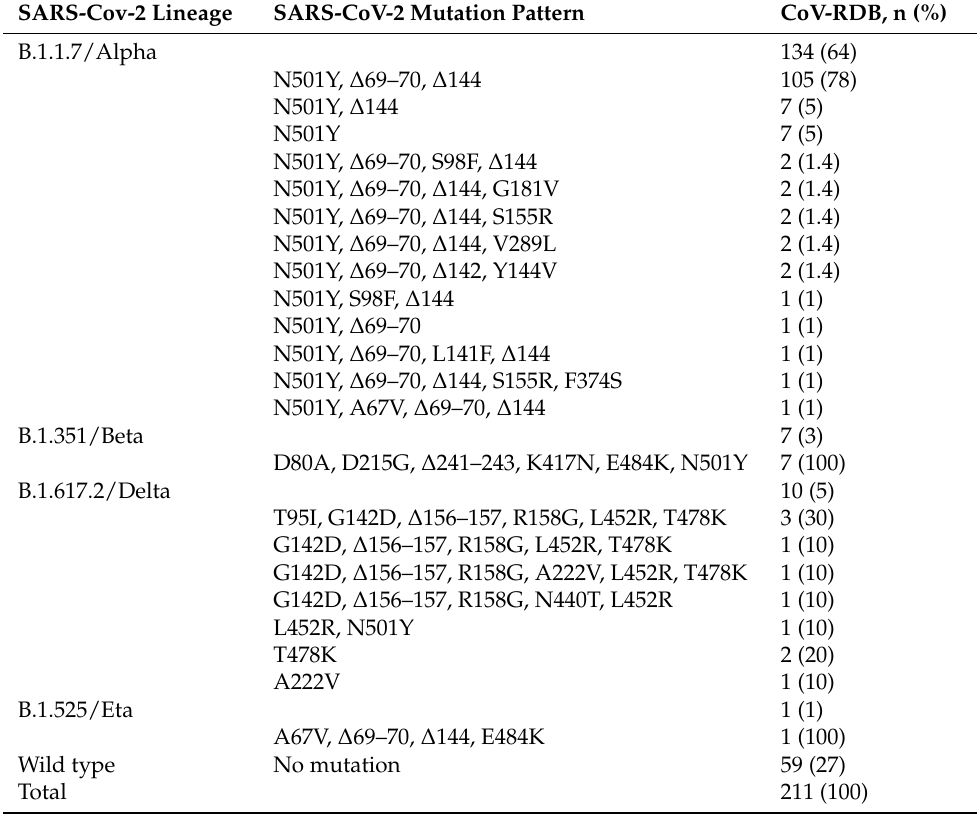
Table 1. Prevalence of SARS-CoV-2 lineage and mutation patterns in the study